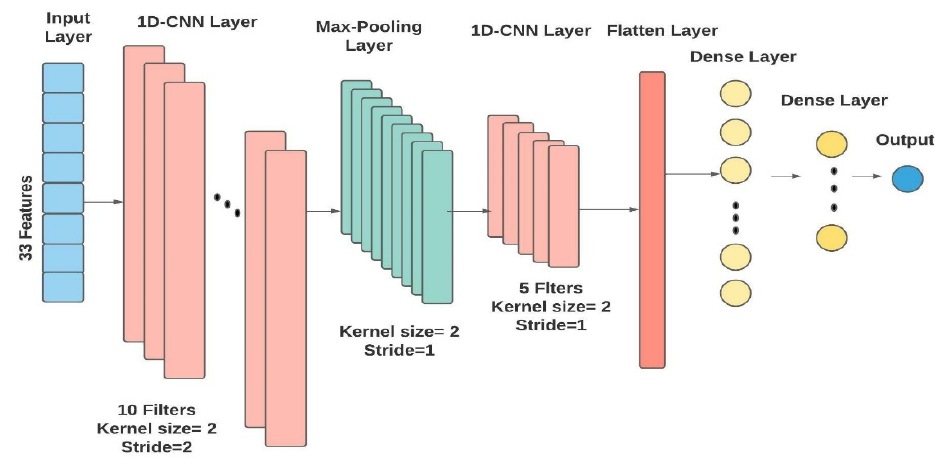
Figure 19. CNN forecasting model.